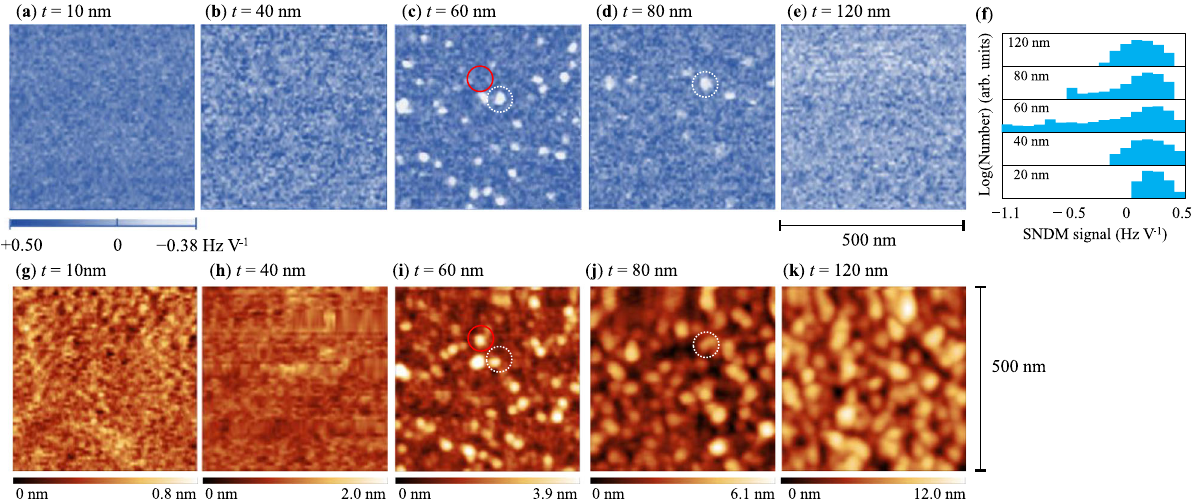
Fig. 3 SNDM analysis of SmIG fi lms with various fi lm thicknesses. a – e SNDM images for 10-, 40-, 60-, 80-, and 120-nm-thick SmIG fi lms in 500 × 500 nm area. Representative dielectric domains are circled by broken white lines in ( c ) and ( d ). f Histograms of SNDM signals with different fi lm thicknesses. g – k Topographic images for 10-, 40-, 60-, 80-, and 120-nm-thick fi lms measured in the same areas as ( a – e ). Solid red and broken white circles in ( i ) and ( j ) indicate the same positions as those in ( c ) and ( d ),